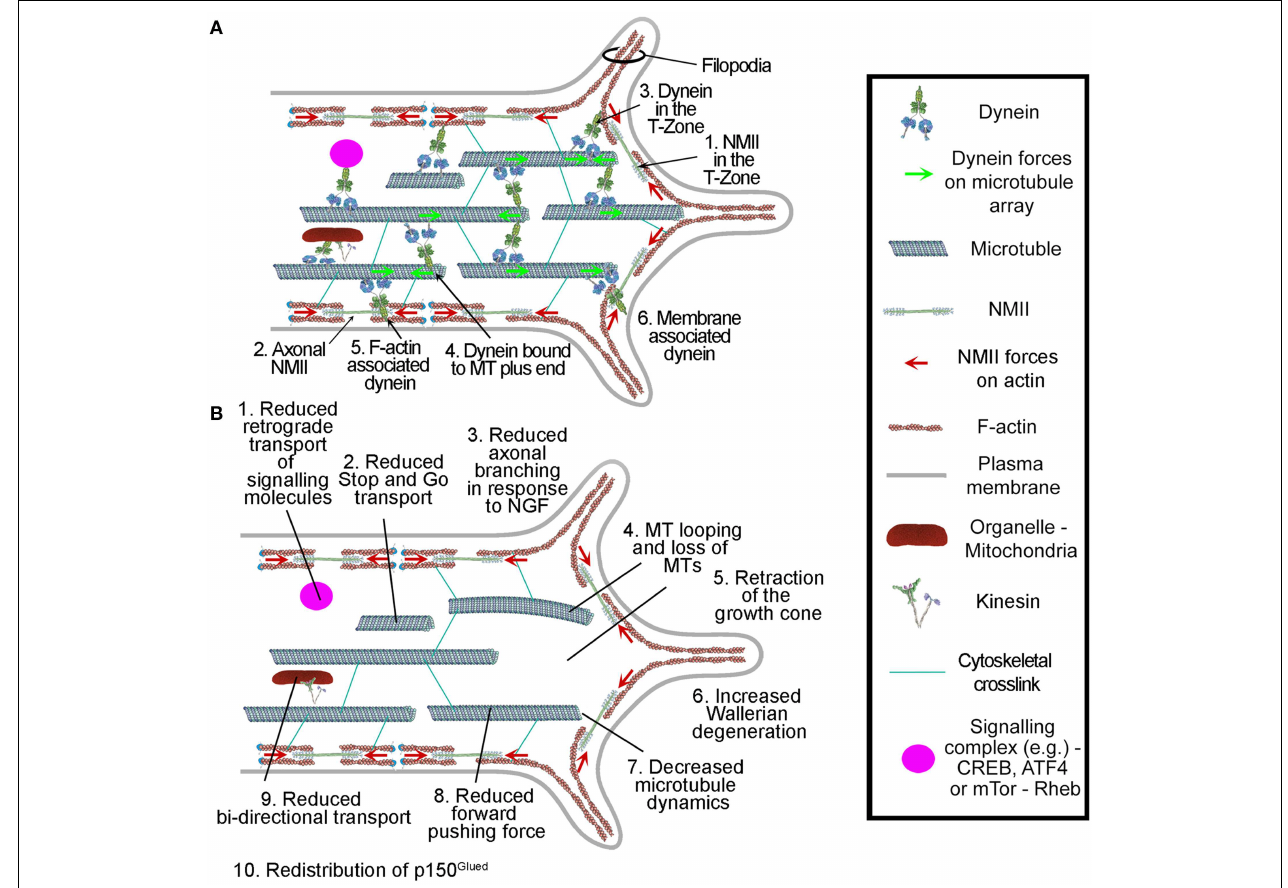
FIGURE 3 | Summary of the roles of dynein in axons and growth cones. (A) Dynein localization and interactions in axons and growth cones. (B) Reported effects of dynein depletion/inhibition on axons and growth cones. All but items 2 and 7 were observed through chronic manipulation of dynein and also using